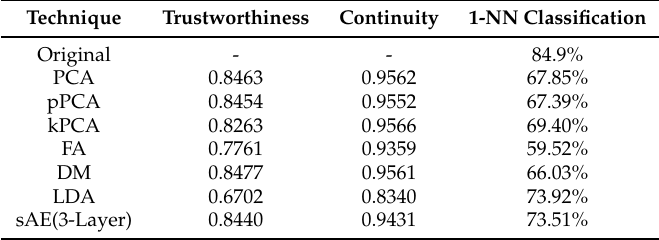
Table 6. Trustworthiness and continuity scores (including weighting) for the different dimensionality reduction techniques (higher values are better), and classification accuracy of 1-nn classification